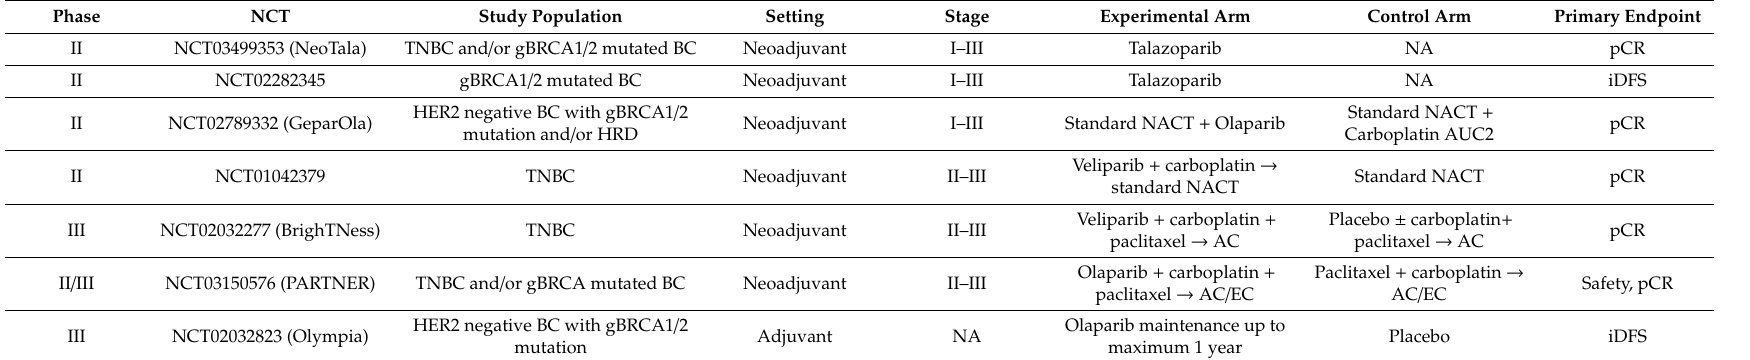
Table 2. Ongoing (neo)-adjuvant phase II-III trials with PARP